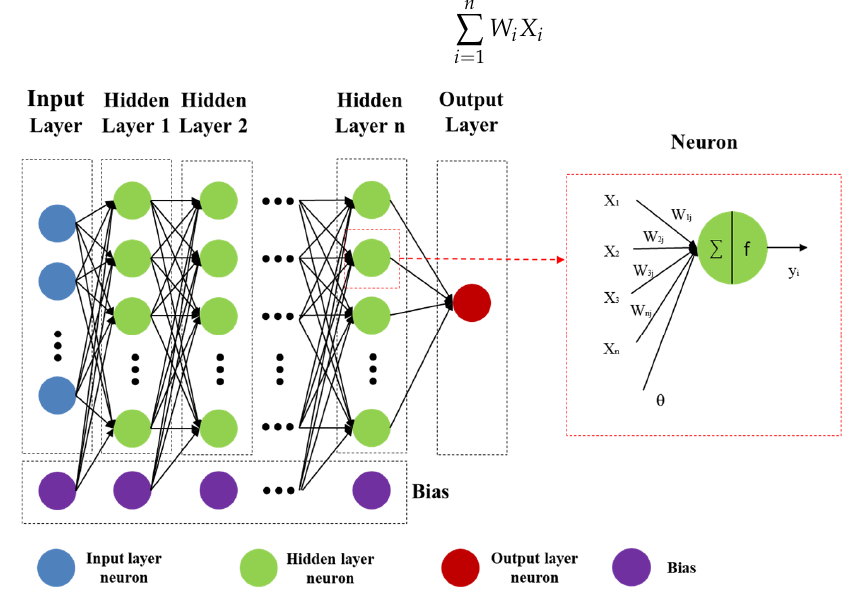
Figure 2. Typical structure of multilayer neural network.